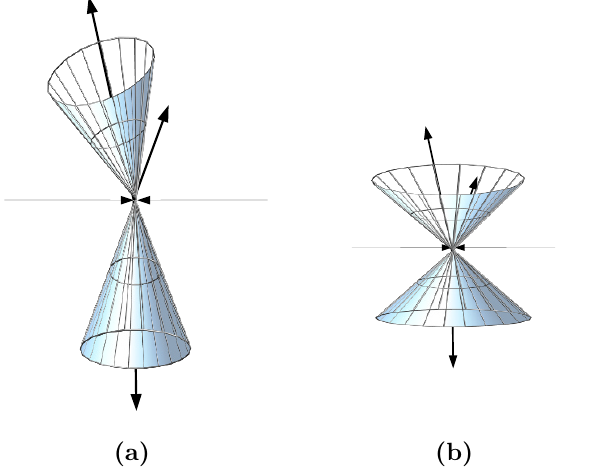
Figure 3 . An illustration of clustering the same three-parton event with smaller (a) and larger (b) values of R